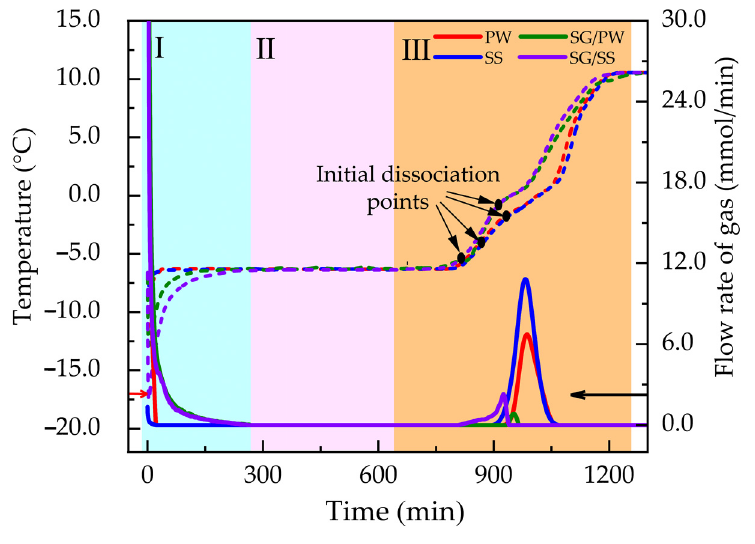
Figure 4. Changes in temperature and flow rate of gas during the first entire dissociation processes of hydrates frozen at − 6 °C and formed within the four experimental media.